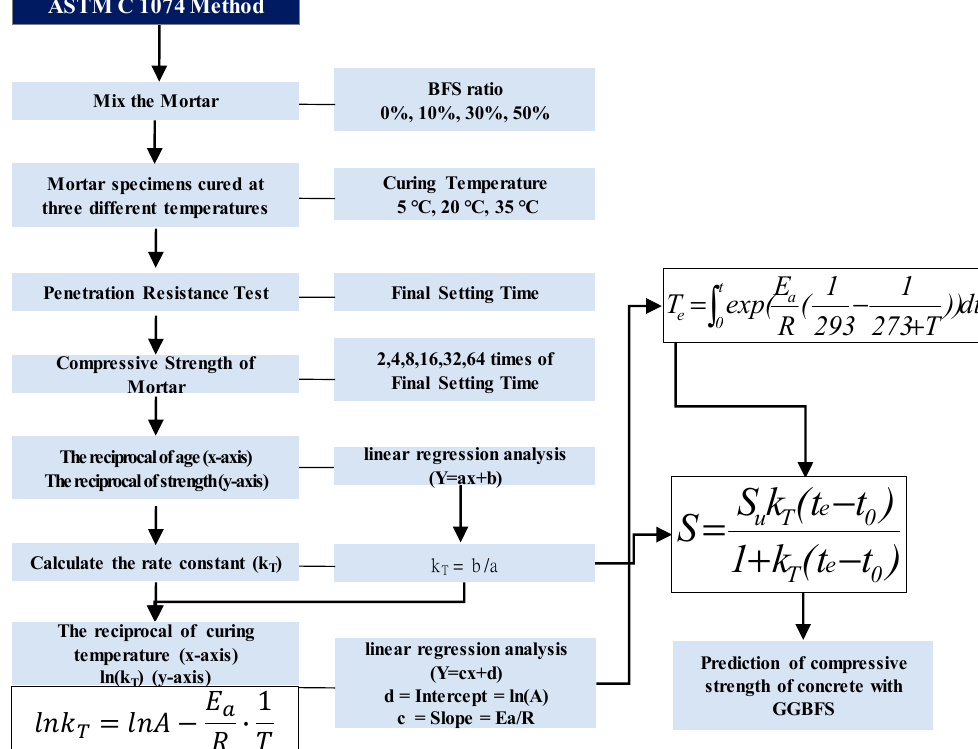
Figure 1. Calculation of E a and estimation of compressive strength of concrete according to ASTM C 1074.